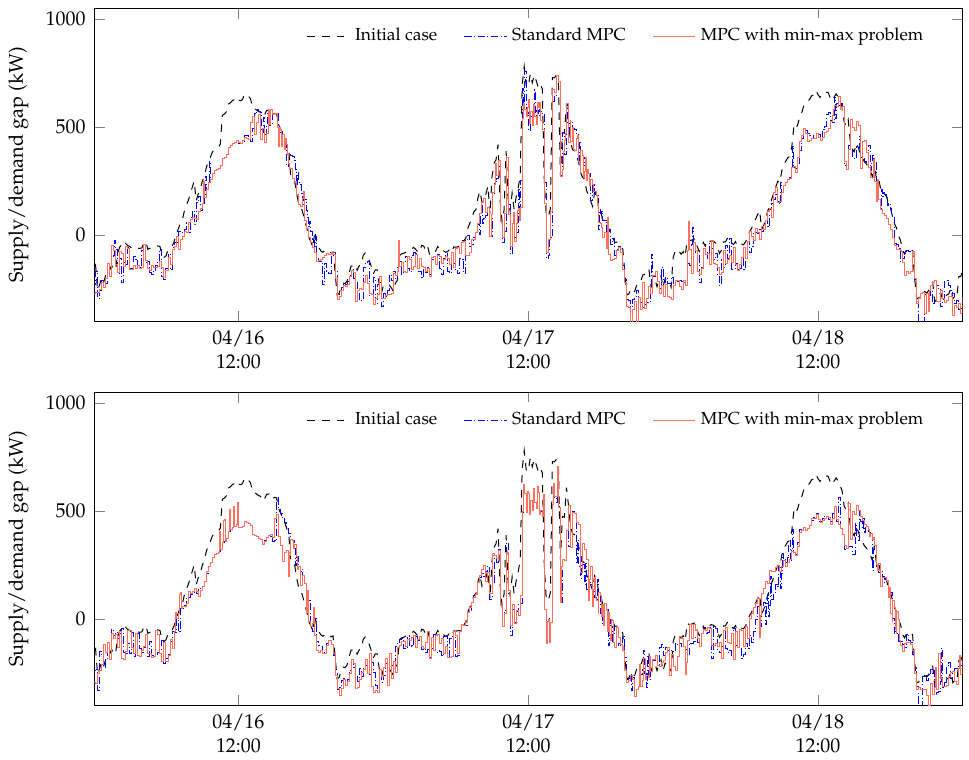
Figure 11. Gap between power supply and demand within the power distribution grid for the standard MPC strategy compared to the one using a min–max problem and to the initial case, displayed for a 4 h sliding window ( top ) and a 10 h sliding window ( bottom